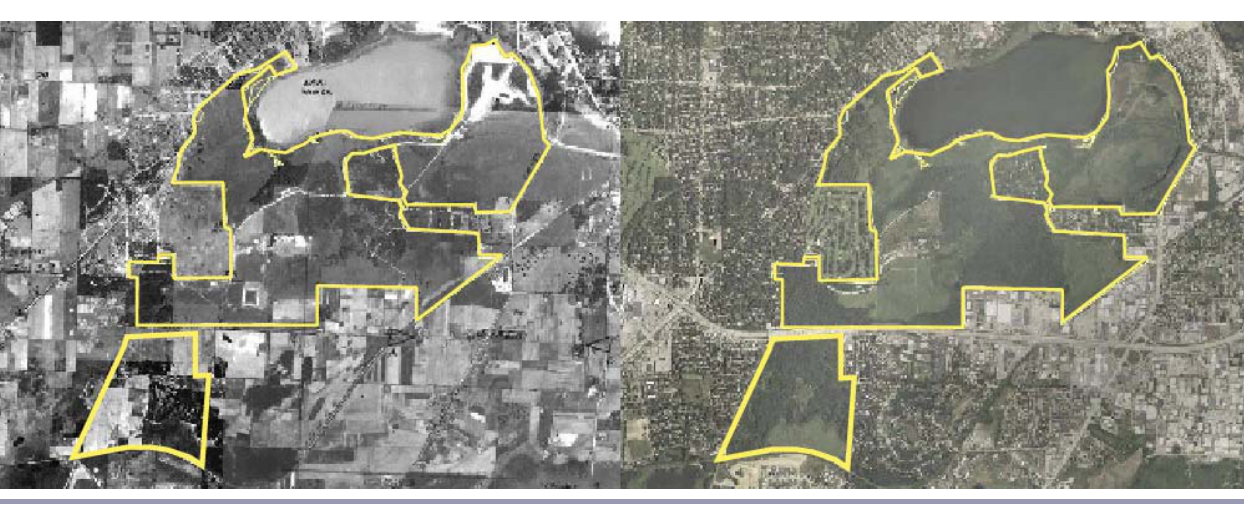
Fig. 1. Seventy-one years of landscape change surrounding the University of Wisconsin-Madison Arboretum (1937, left; 2008, right). Images are from the U.S. Department of Agriculture, with the 2008 Arboretum boundary added by Mark Wegener, Arboretum Database